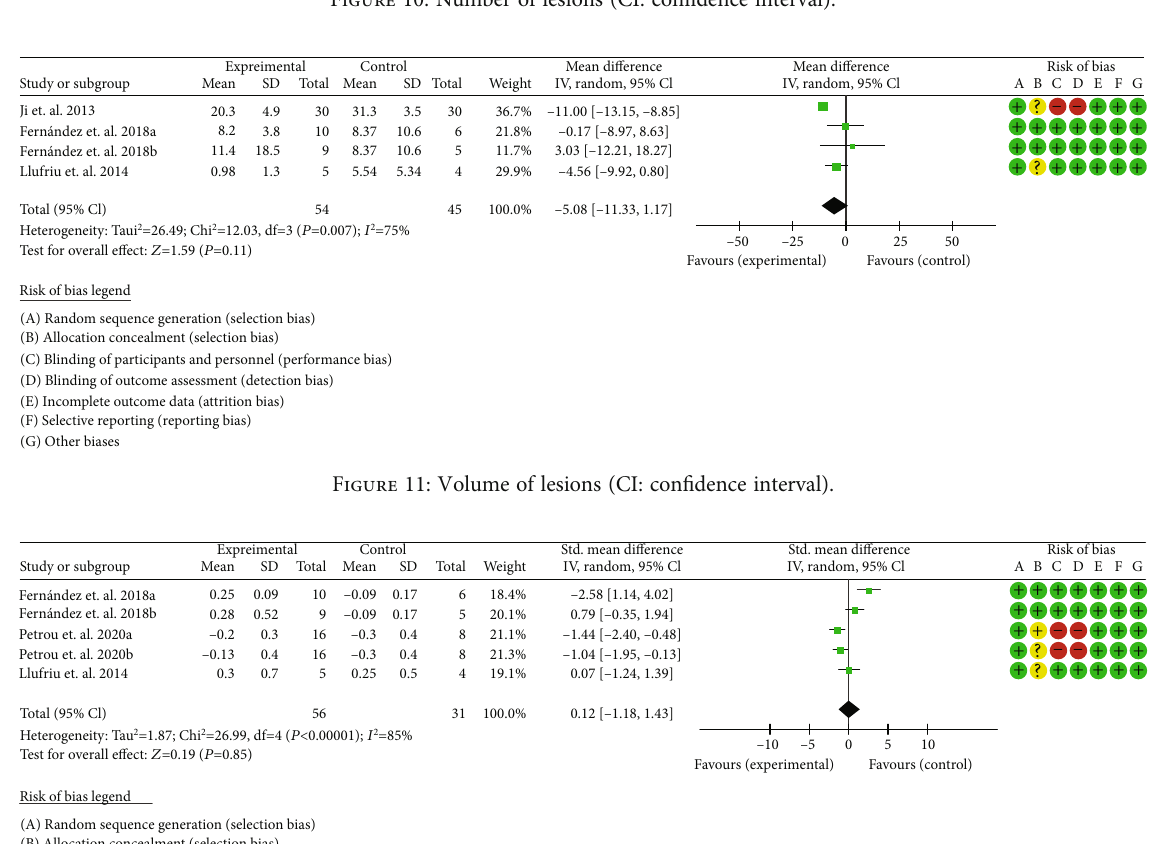
Figure 10: Number of lesions (CI: con fi dence interval).